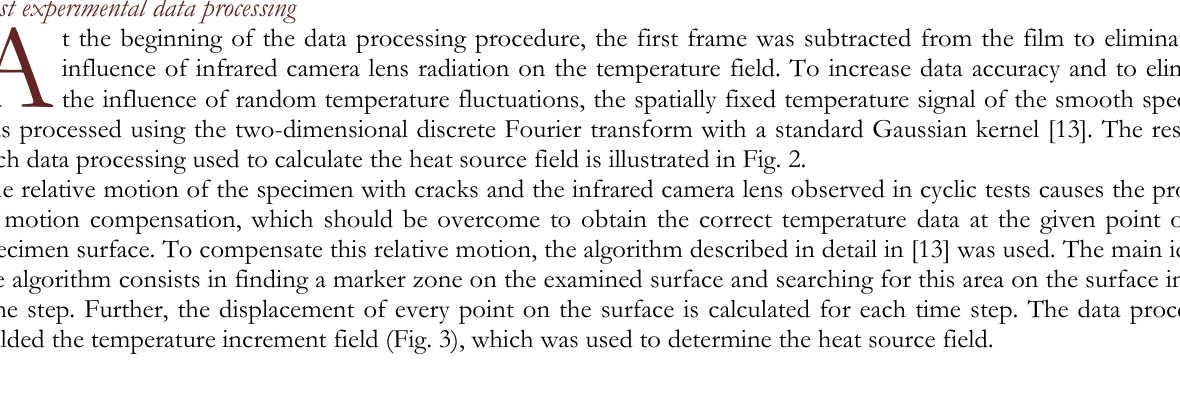
E XPERIMENTAL DATA PROCESSING AND STORED ENERGY DETERMINATION